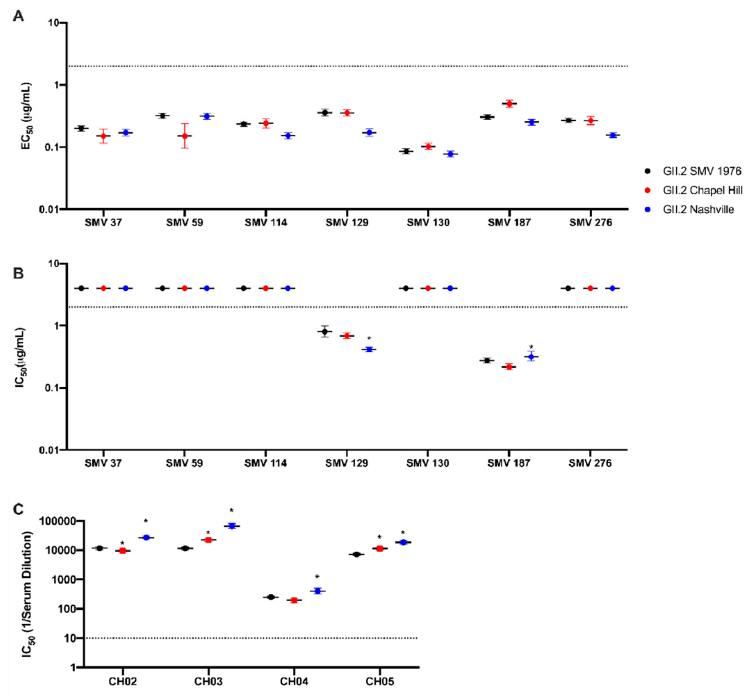
Figure 2. Antibody epitopes are conserved between 2017 GII.2 strains and GII.2 SMV 1976. Contemporary GII.2 Virus Like Particles (VLP) binding to mouse monoclonal antibodies to GII.2 SMV 1976 VLP (Swanstrom et al., 2014). EC 50 and IC 50 values were calculated for sigmoidal dose-response curves fit to the percent maximum binding for EIA ( A ), and mean percent control binding for antibody inhibition of ligand binding, blockade assays by mAb ( B ), or human sera from GII.2 infected donors ( C ) . Error bars represent 95% confidence intervals. Non-blockade mAbs were assigned an IC 50 of 4 µg/mL for statistical analysis and are denoted by data markers on the graph above the upper limit of detection (dashed line) for visual comparison. *, VLP with significantly different blockade titer from that of GII.2.SMV 1976 with p < 0.05.